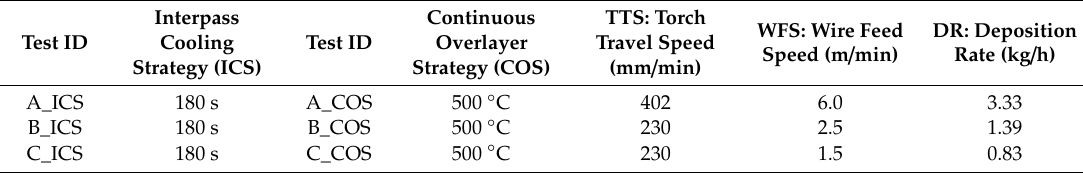
Table 2. Process parameters for the manufacture of IN718 WAAM wall.